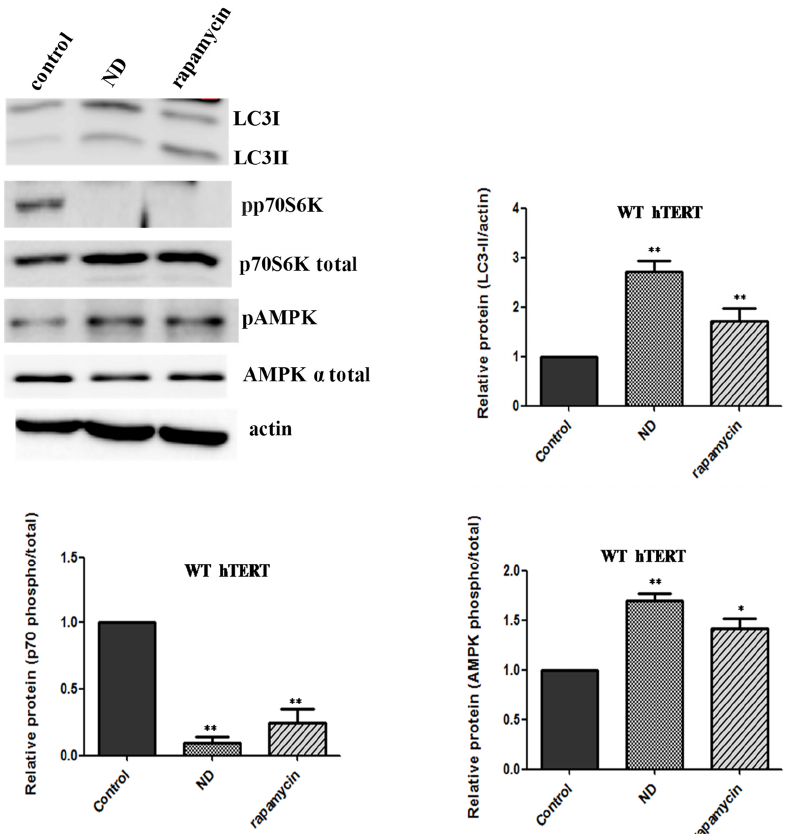
Figure 4. Lack of upregulation of autophagy in WT hTERT is not due to defects in signaling. The WT hTERT cells were put under conditions of nutrient deprivation (ND) or treated with 10 nM rapamycin (an mTOR inhibitor) for two hours. Autophagy activation was evaluated utilizing the LC3-II and AMPK antibodies. Phosphorylation of p70S6K (Thr 389), which is a downstream target of mTOR and classically used as a surrogate of mTOR activity, was probed. Actin was used as loading control. Graphs show average data from three independent experiments ± SEM. Student t-test as compared nutrient deprivation and rapamycin to untreated WT hTERT control. Statistical significance was determined at a p value < 0.05* and 0.01**.